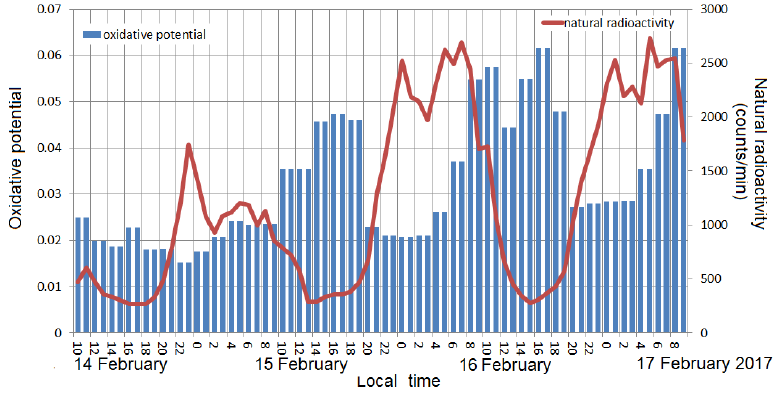
Figure 8. Time series of the oxidative potential measured on 14, 15, 16 and 17 of February 2017. The oxidative potential is expressed in arbitrary units, i.e., fluorescence intensity resulting from the oxidation of the non-fluorescent 2 (cid:48) ,7 (cid:48) -dichlorofluorescin (DCFH) to the fluorescent dichlorofluorescein (DCF) in the presence of horseradish peroxidase (HRP). For reference, data of natural radioactivity (i.e., mixing properties of the lower atmosphere) are indicated.